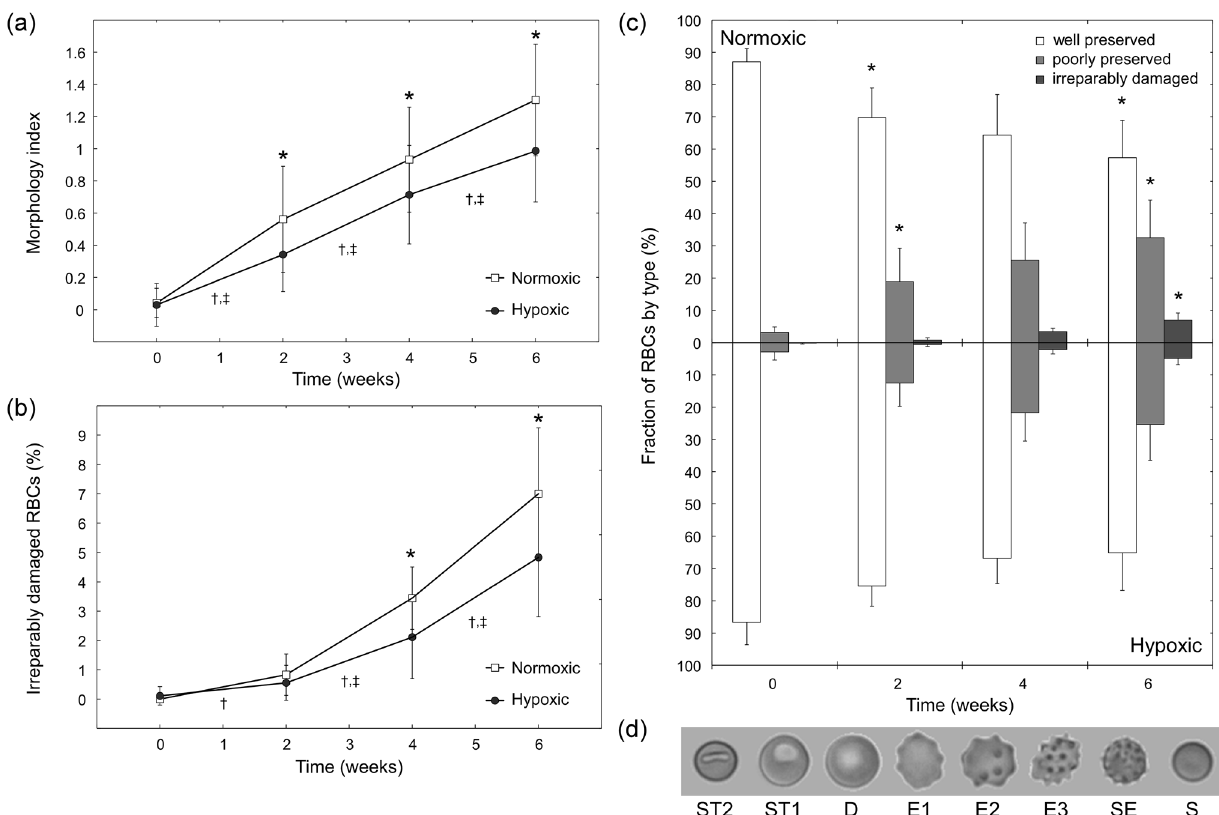
Figure 5. Deterioration of RBC morphology during 6-week hypothermic storage under normoxic and hypoxic conditions. ( a ) Overall morphology index (MI). ( b ) The fraction of ‘irreparably damaged’ RBCs (SE and S) in the overall population of stored RBCs. ( c ) The change in distribution of all RBC within a unit among well- preserved (D and E1, white bar), poorly-preserved (E2 and E3, gray bar) and irreparably damaged (SE and S, dark gray bar) fractions in each unit. Values shown are mean ± standard deviation (n = 9 RBC units). Statistically significant differences ( p < 0.05) between normoxic and hypoxic storage of the same duration are marked by an asterisk (*). Statistically significant differences ( p < 0.05) between subsequent weeks of storage are marked by a dagger (†) for normoxic, and a double dagger (‡) for hypoxic storage. ( d ) Representative images of RBC morphologies: discocyte (D), echinocyte I (E1), echinocyte II (E2), echinocyte III (E3), sphero-echinocyte (SE), spherocyte (S), stomatocyte I (ST1) and stomatocyte II